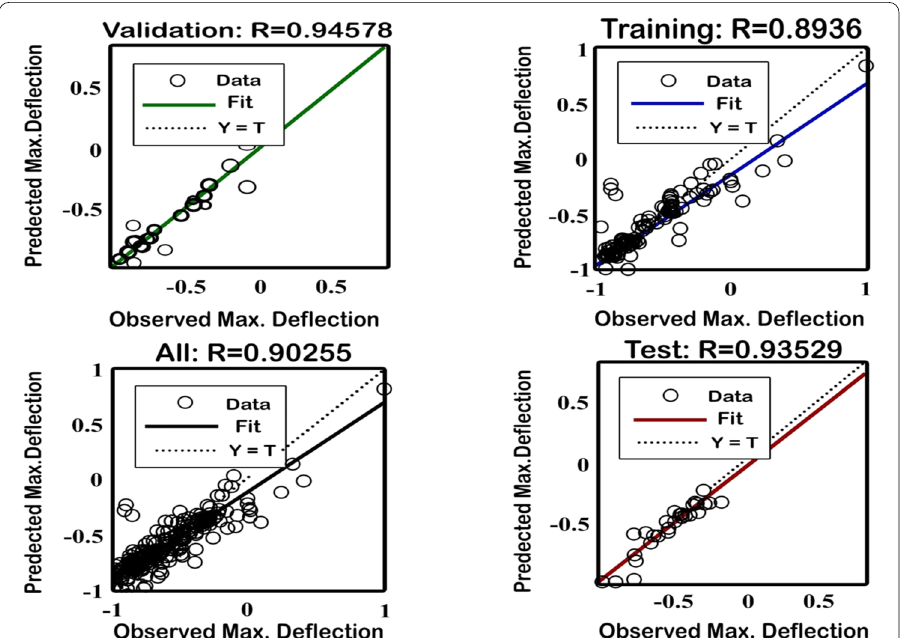
Fig. 6 Comparison between predicted and Observed max. deflection δ H for All data set, Training data Set, Testing Data Set, and Validation Data Set